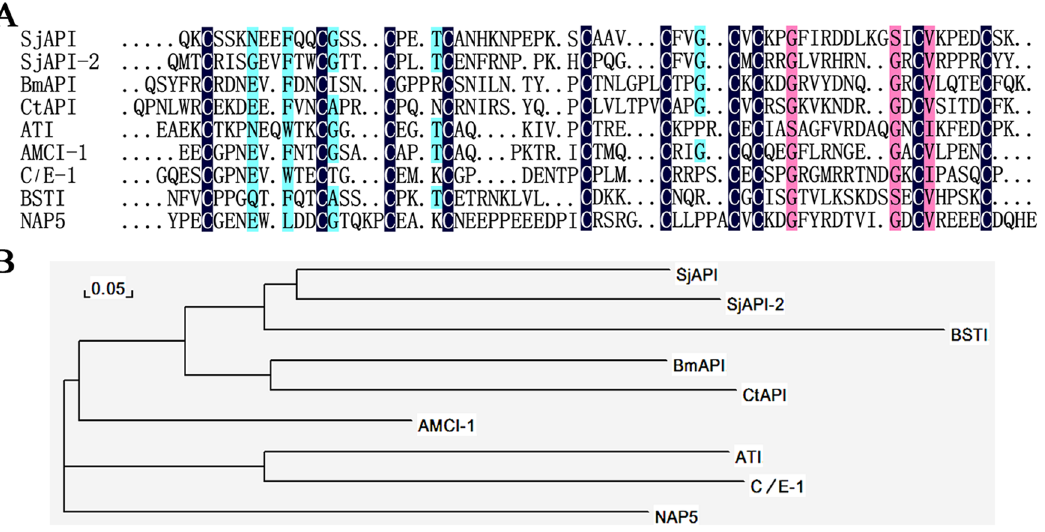
Figure 1. Members of the first Ascaris -type animal toxin family. (A) Amino acid sequence alignments of SjAPI, SjAPI-2, CtAPI, and BmAPI with known representative Ascaris -type peptides. The sequence identities of different Ascaris -type peptides to SjAPI were shown on the right side. (B) A minimum evolution (ME) tree of representative Ascaris -type proteins based on multiple sequence alignment.